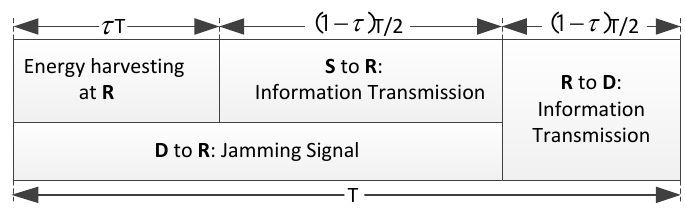
Figure 4. The TS